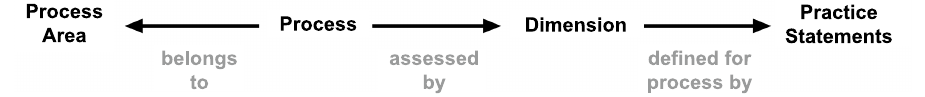
Figure 2. Relationships between processes, practices and